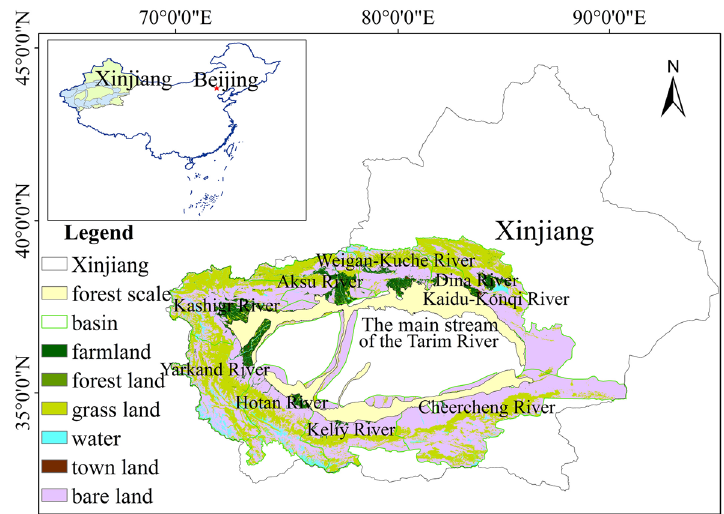
Figure 1. Distribution map of the Tarim River Basin desert riparian forest, Xinjiang,